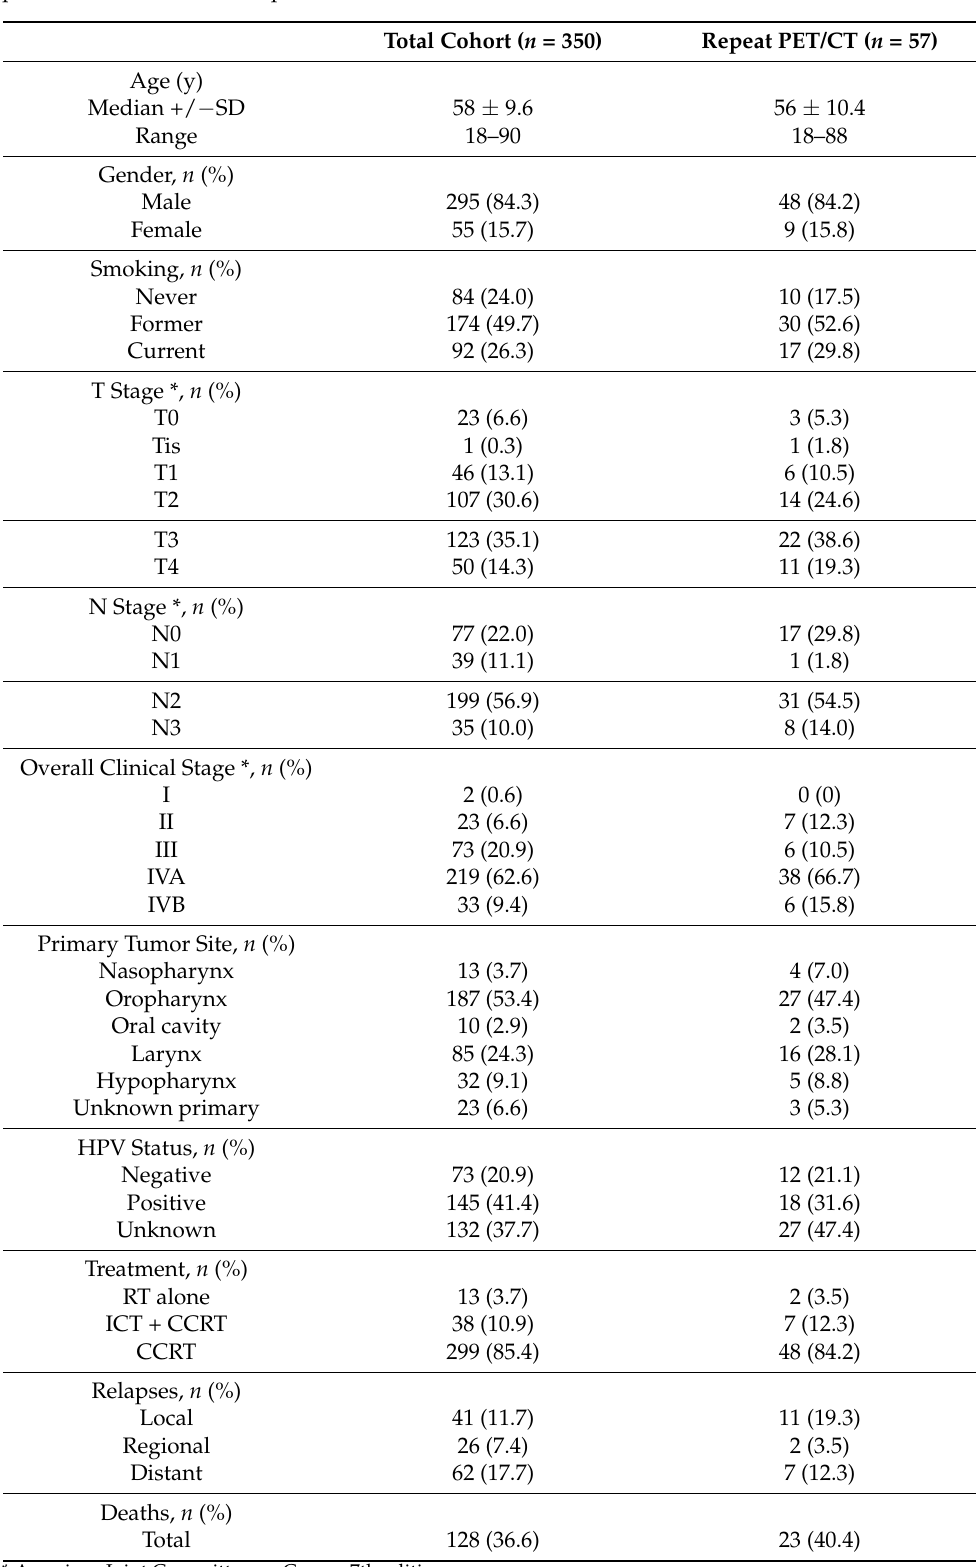
Table 1. Baseline patient, tumor, and radiation treatment characteristics for the total cohort and patients who underwent repeat